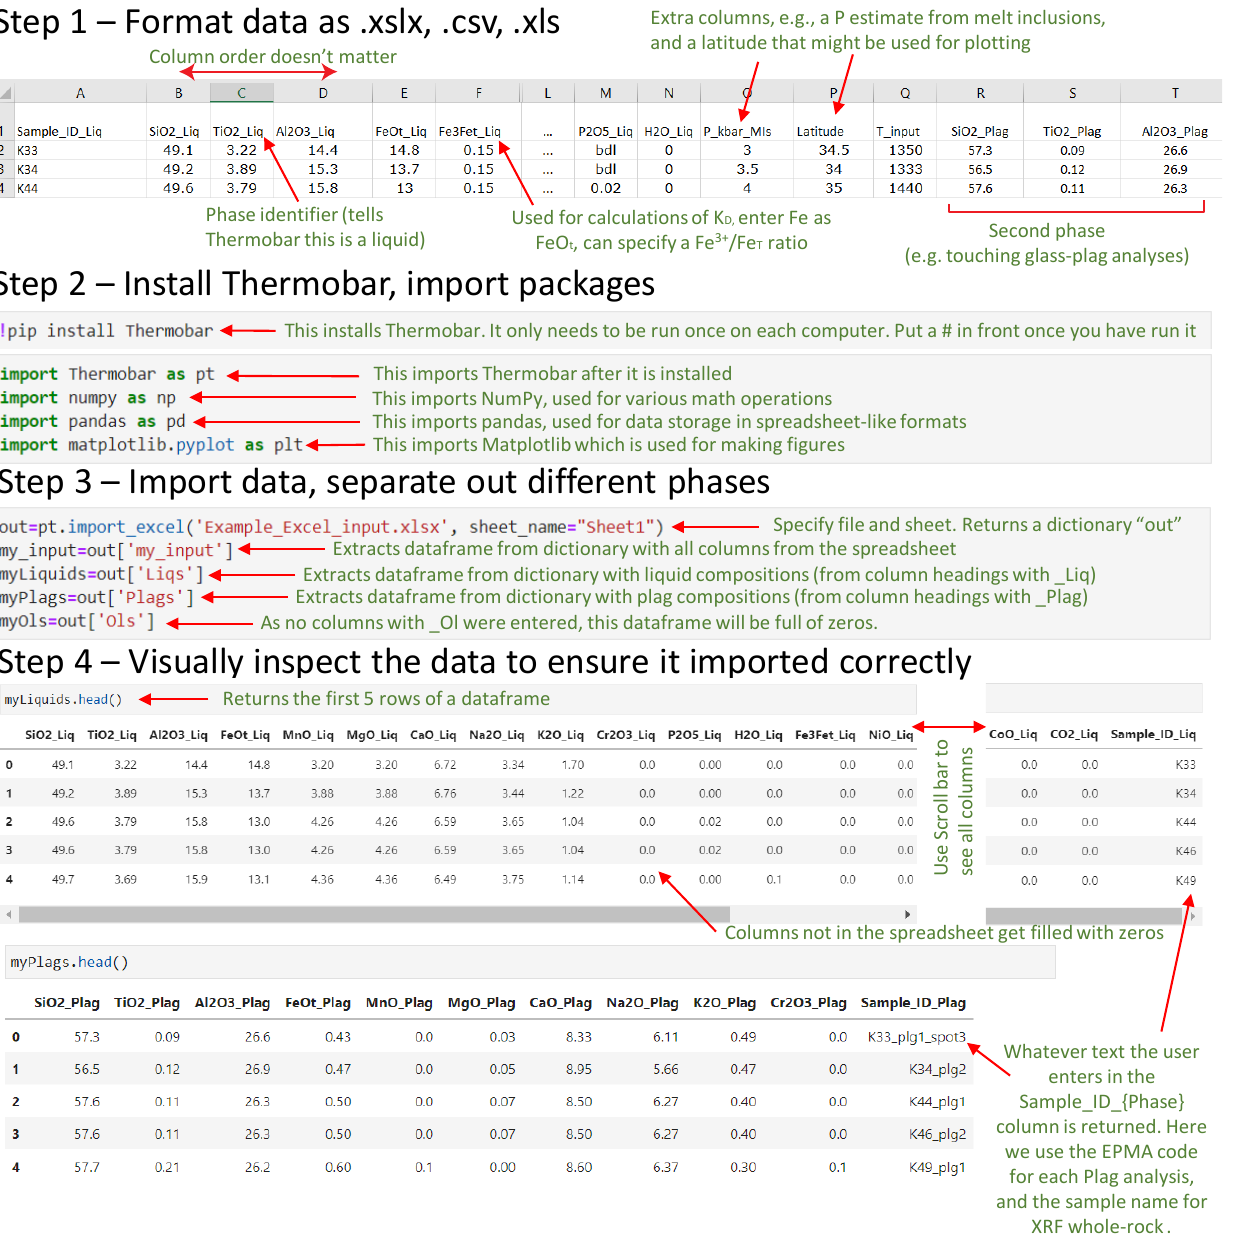
Figure 2: Guide to data input. Step 1 : Format data into a spreadsheet with oxide names followed by _phase. The order of columns does not matter, and other columns can also be included in the input (e.g. estimates of pressure and temperature, additional metadata, spatial data etc.). Step 2 : Thermobar is imported, along with NumPy , pandas and matplotplib . Step 3 : The import_excel function extracts data from this spreadsheet into a set of dataframes with a specific column order. The function returns a dictionary (named " out ") where all these dataframes are stored with keys corresponding to different phases. For example, the dataframe of liquids is extracted from this dictionary using the key " Liqs ". All dictionary keys correspond to the phase identifiers used for inputs with an added "s". If the input does not have specific column headings (e.g. no _Ol, _Kspar ), the dataframe for this phase will be filled with zeros. Step 4 . Dataframes for each phase are inspected to check that the spreadsheet has been read in